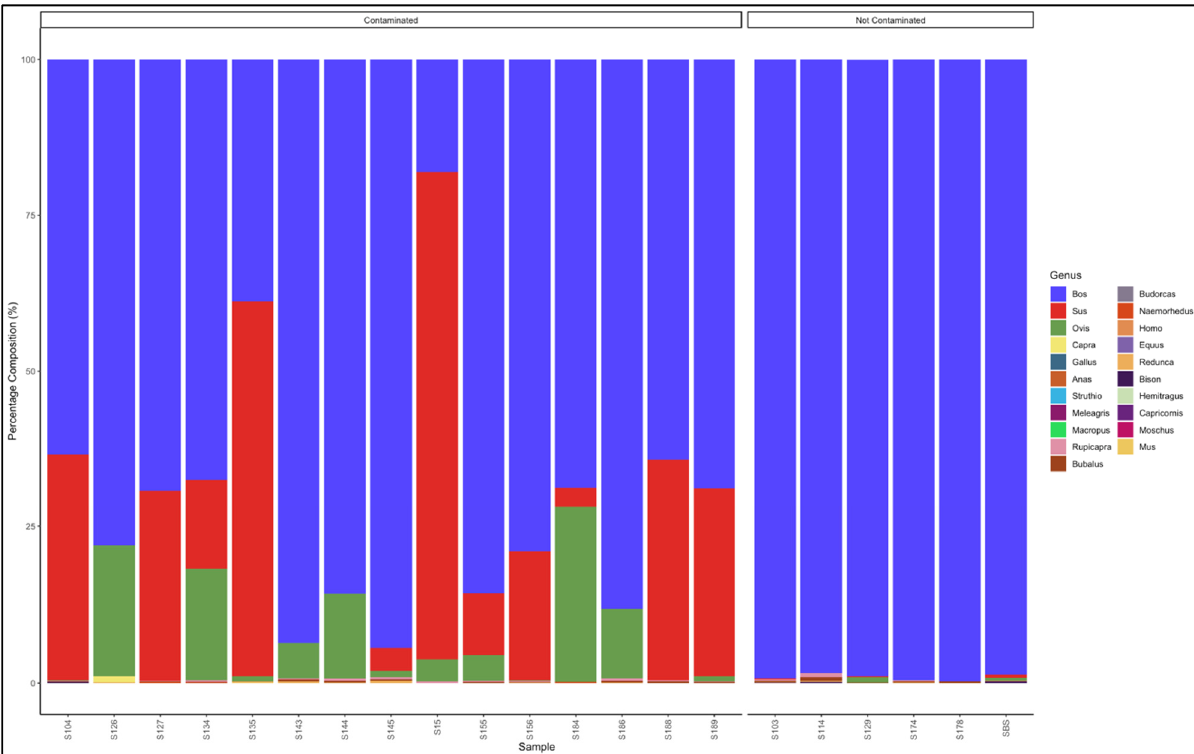
Figure 10 . Percentage composition for sausage samples not specified which species they are from.